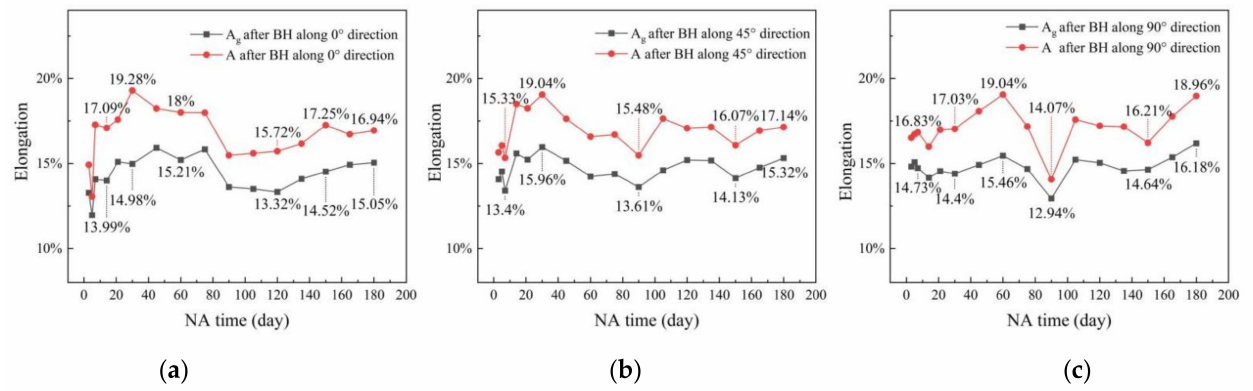
Figure 14. The change curves of A g and A after bake hardening along 0 ◦ ( a ), 45 ◦ ( b ), and 90 ◦ ( c )